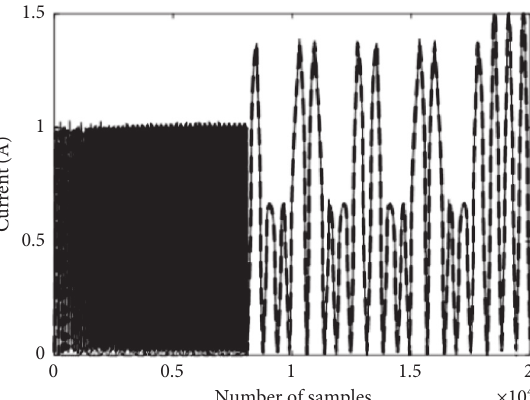
Figure 6: Comparison of current prediction value and target value. Solid line: target value; dashed line: prediction